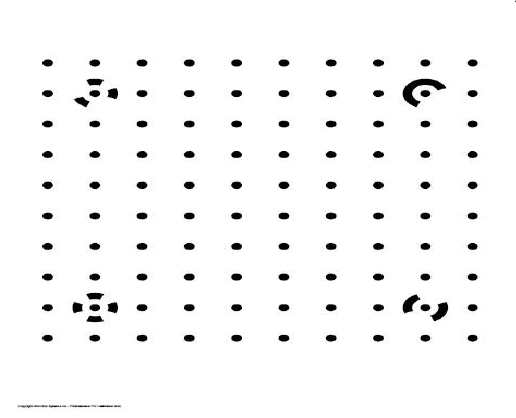
Figure 2. Camera calibration grid for Photomodeler